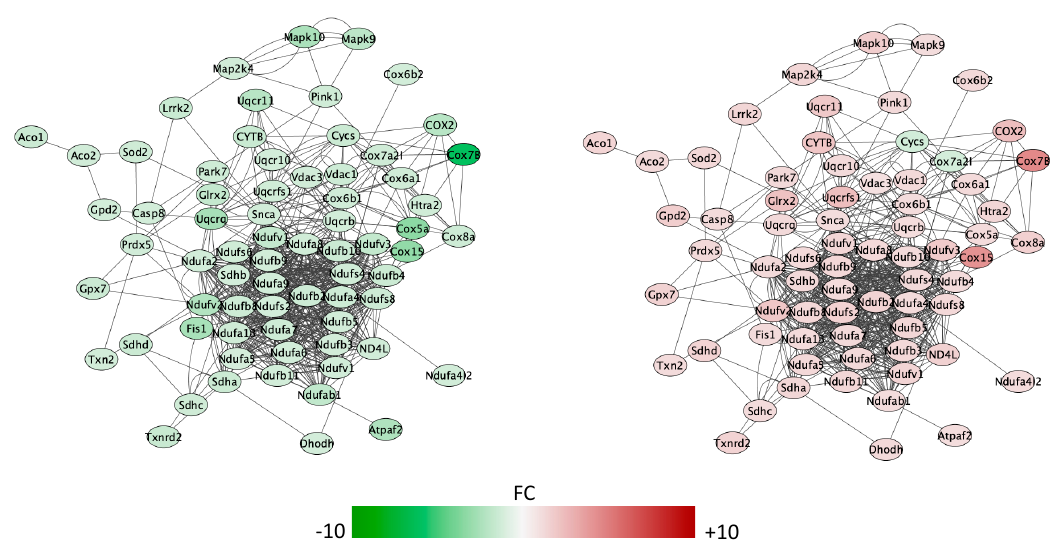
Figure 4. Mitochondrial dysfunction pathway. Genes with overlapping actions observed in ( A ) Tat − / Meth vs. Tat − / Sal and in ( B ) Tat +/ Meth vs. Tat − / Meth and assigned to mitochondrial dysfunction were loaded into Cytoscape via Genemania; significant changes ( p < 0.01) associated to assigned comparisons were visualized by loading node attributes. Tat − / Meth vs. Tat − / Sal p = 4.80 × 10 − 15 and Tat +/ Meth vs. Tat − / Meth p = 2.19 × 10 − 11 , with 65.5% and 57.9% overlap, respectively.